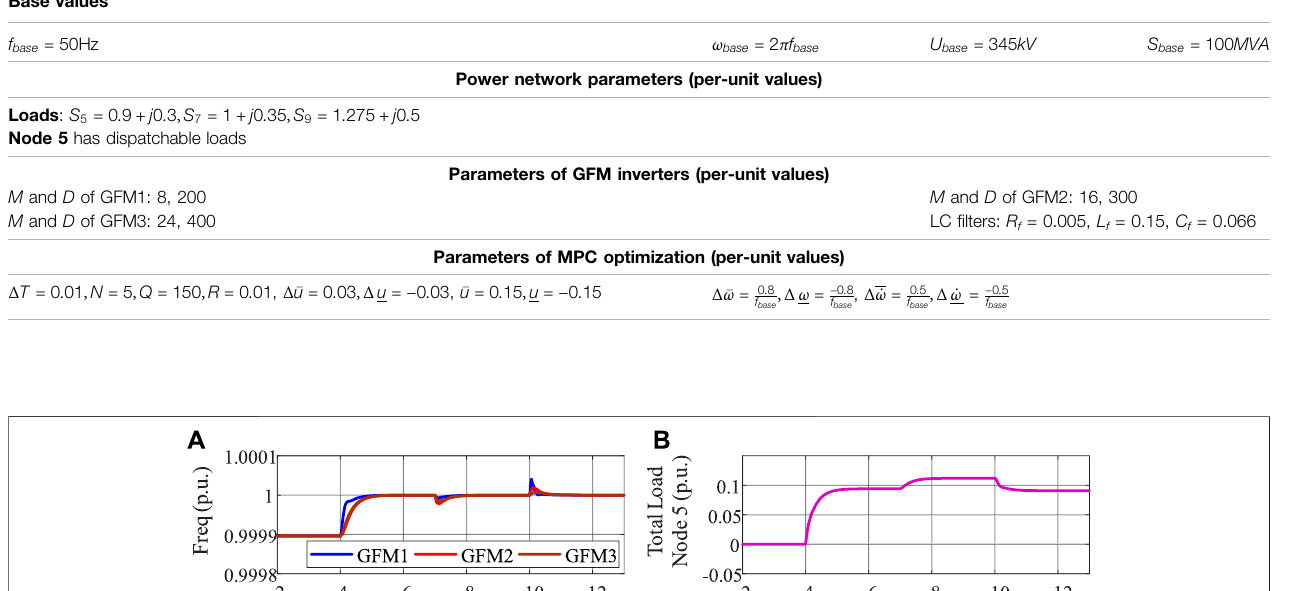
TABLE 2 | Parameters of the IEEE 9 bus test system with three GFM inverters. Base values